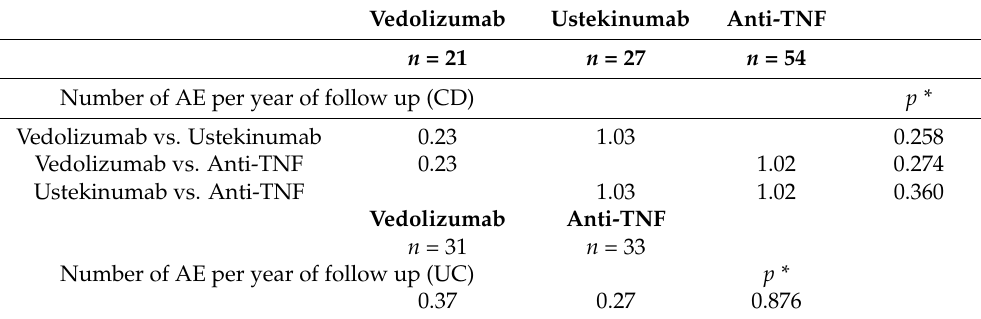
Table 3. Comparative safety in patients treated with vedolizumab, ustekinumab or anti-TNF.